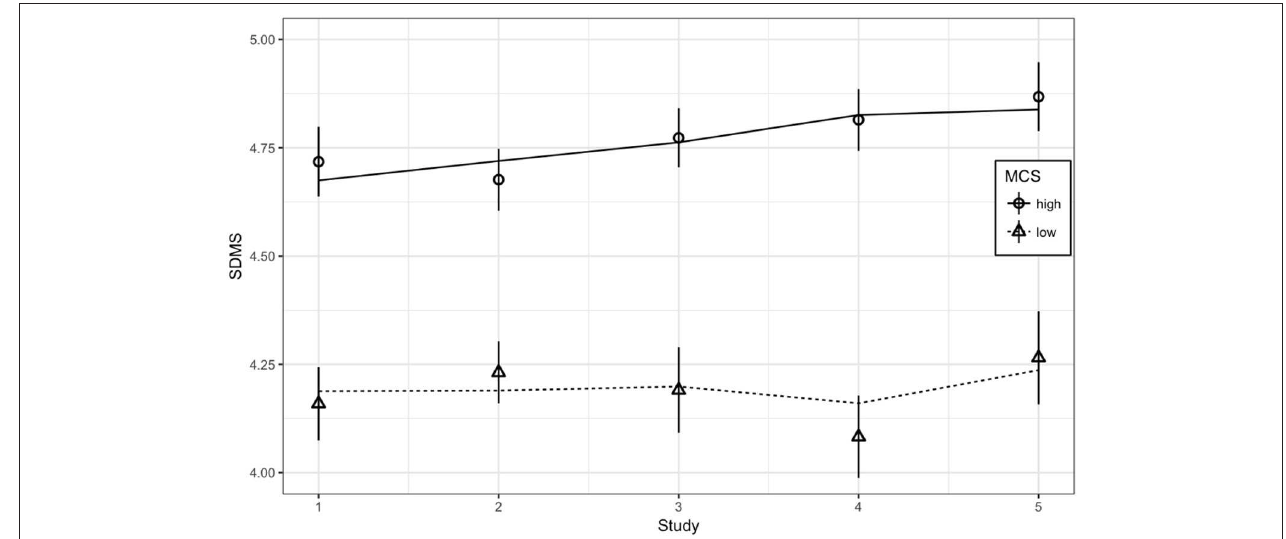
FIGURE 1 | Estimated growth curves of SDMS for individuals with low and high initial scores of MCS.